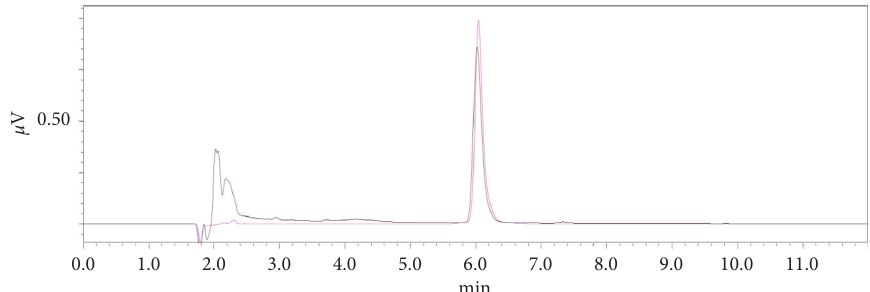
Figure 5: Typical chromatogram for the degraded levamisole standard with 0.5M HCL ( : intact drug; : degraded drug).